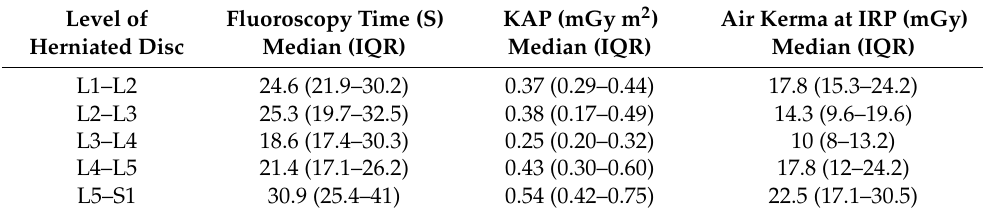
Table 2. Summary of fluoroscopy time, KAP, and air kerma at IRP in different levels of lumbar disc herniation.